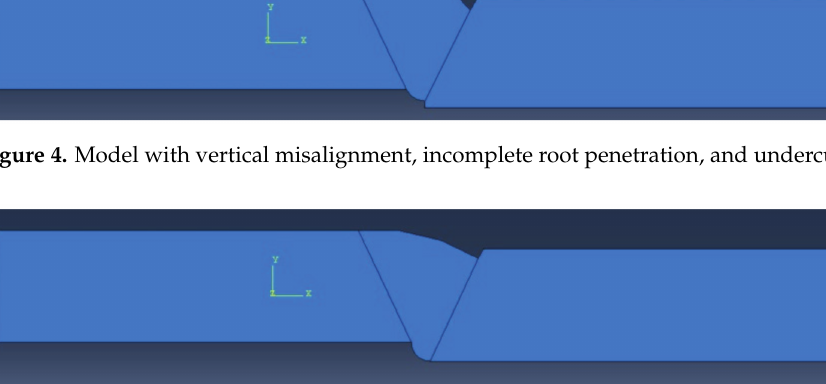
Figure 5. Model with vertical misalignment, undercut, and slight excess root